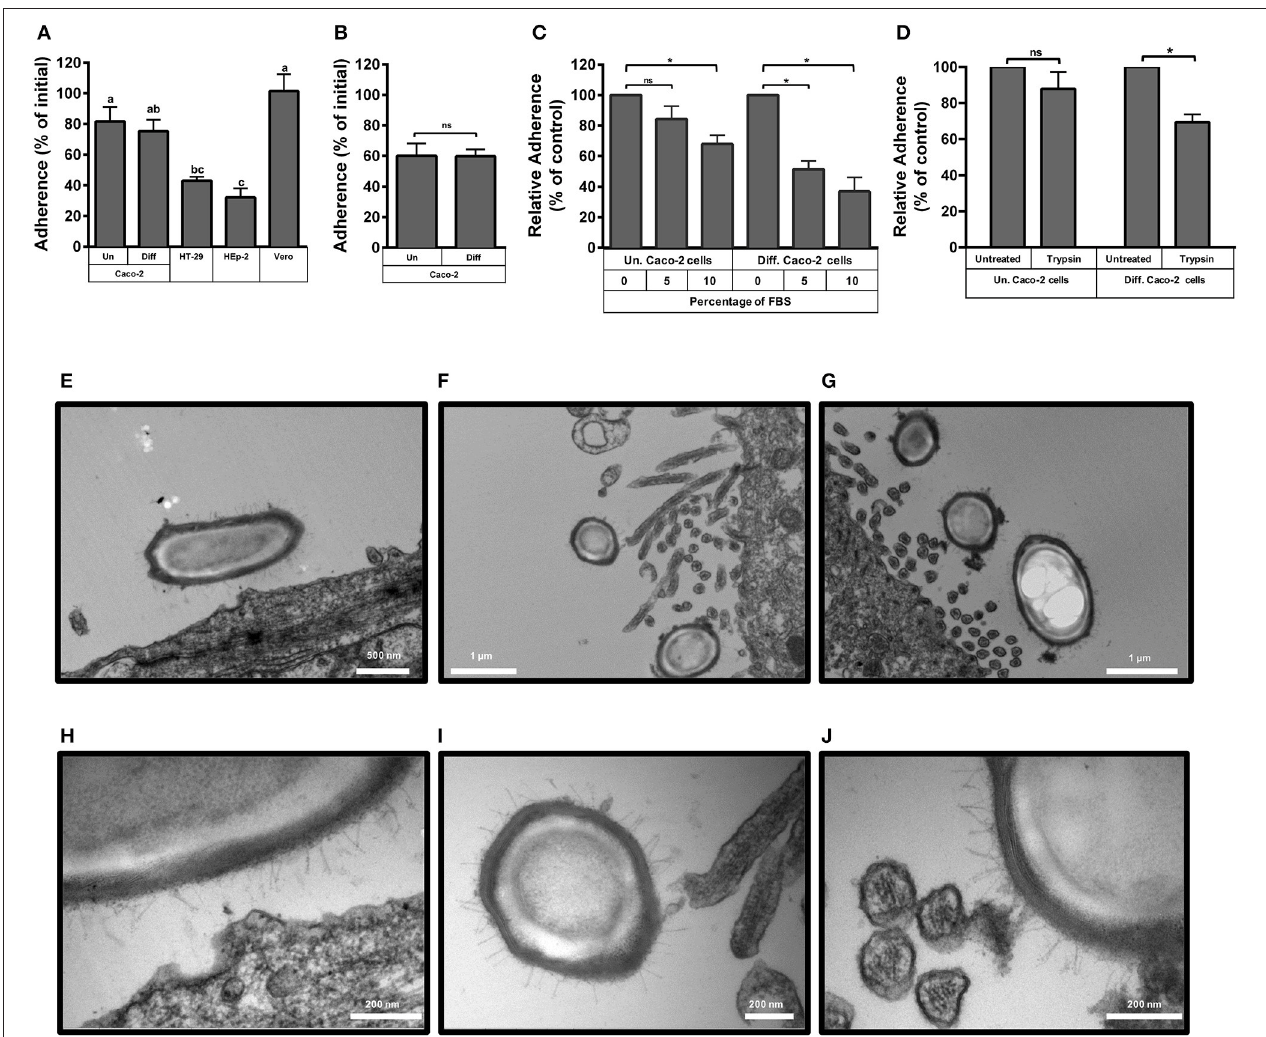
FIGURE 1 | Adherence of C. difficile epidemic R20291 spores to intestinal epithelial cell lines. (A) Monolayers of undifferentiated (Un) and differentiated (Diff) Caco-2, HT-29, Hep-2 and Vero cells were infected at a MOI of 10 with C. difficile R20291 spores for 3h at 37 ◦ C and adhered spores were determined as described in the Methods section. Pre-reduced monolayers of undifferentiated (Un) and differentiated (Diff) Caco-2 cells were infected for 3h at 37 ◦ C under anaerobic conditions with an MOI of 10 of C. difficile R20291 vegetative cells and the percentage of adherence was determined as described in the Method section. (B) Pre-reduced monolayers of undifferentiated (Un) and differentiated (Diff) Caco-2 cells were infected at an MOI of 10 with vegetative cells of C. difficile R20291 strain for 3h at 37 ◦ C under anaerobic conditions and the percentage of adherence was determined as described in the Method section. (C) The effect of fetal bovine serum (FBS) concentration on the adherence of C. difficile R20291 spores to monolayers of undifferentiated (Un) and differentiated (Diff) Caco-2 cells was determined by pre-incubating C. difficile spore suspensions with 0, 5, or 10% FBS prior to infection at an MOI of 10 for 3h at 37 ◦ C as described in the Method section. (D) Effect of trypsin treatment of Caco-2 cells on spore adherence. The presence of putative cellular receptors was determined by trypsin-treating monolayers of undifferentiated (Un.) or differentiated (Diff.) Caco-2 cells for 5 min prior to infection with C. difficile spores at an MOI of 10 for 3h at 37 ◦ C, as described in the Method section. Data represents the average of three independent experiments and error bars are standard error of the mean. In (A) , similar letters indicate no significant difference, while different letters indicate statistical difference (ANOVA; Bonferroni post-test; P < 0.05) between cell lines. Asterisks (*) in (B–D) denote statistical differences with a P < 0.01; ns, not significant. (E–J) Transmission electron micrographs of infected monolayers of Caco-2 cells. Monolayers of undifferentiated (E,H) and differentiated (F,G,I,J) Caco-2 cells were infected for 3 h at an MOI of 10 with epidemic spores of C. difficile strain R20291, unbound spores were rinsed off and infected monolayers were processed for transmission electron microscopy as described in the Method section. (H–J) Are magnified micrographs from those shown in (E–G) , respectively. White scale bars are shown in each micrograph.